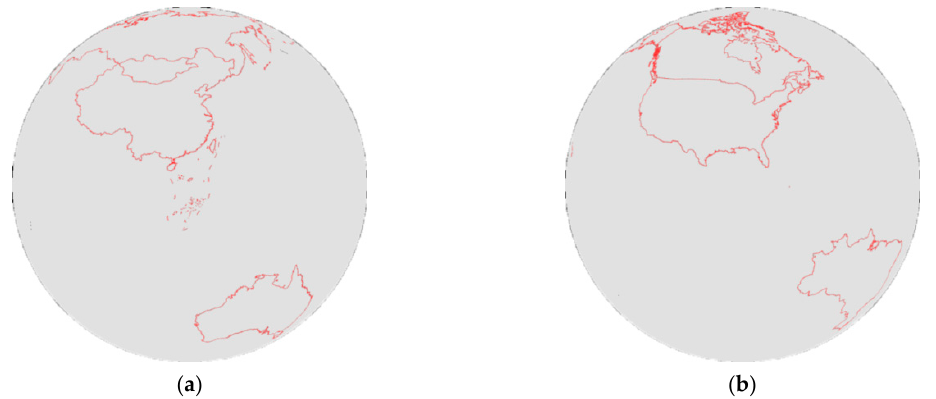
Figure 16. Results of the vector lines using hexagonal grids: the vector lines are the boundaries of different countries (source—own study). ( a ) contains China, Russia and Australia and ( b ) contains America, Canada and Table 4. Discretization efficiency (number of cells rasterized ms -1 ) of the spherical vector lines using the proposed index arithmetic